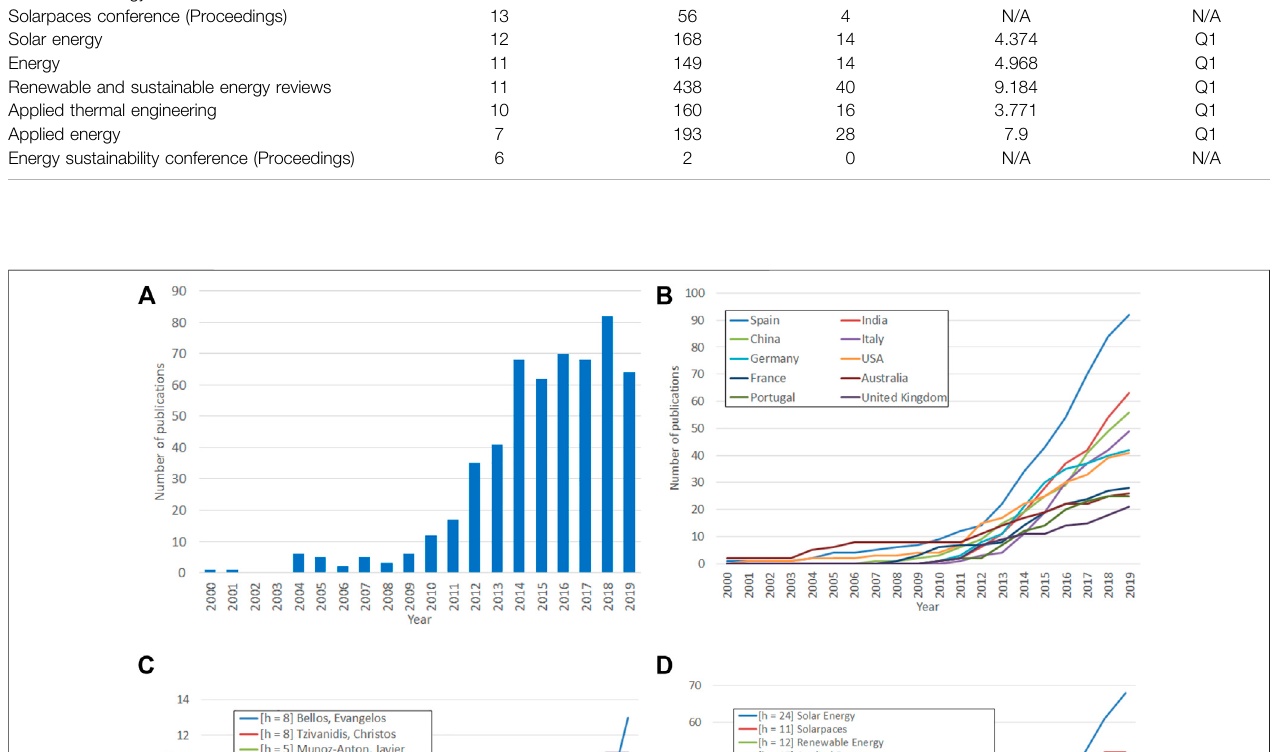
Frontiers in Mechanical Engineering |